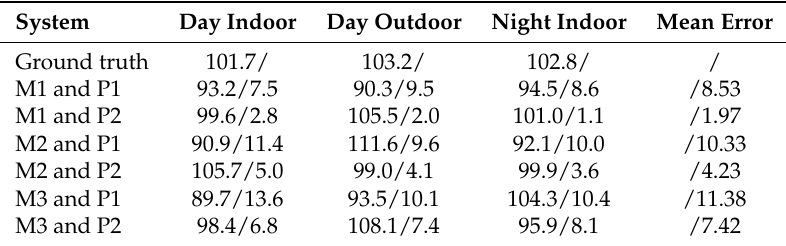
Table 3. Mean and errors of heart rates in BPM estimated by different methods when the subject performed strenuous exercise (pushups). “M1 and P2” represents the results of the proposed system. The values to the right of the/represent